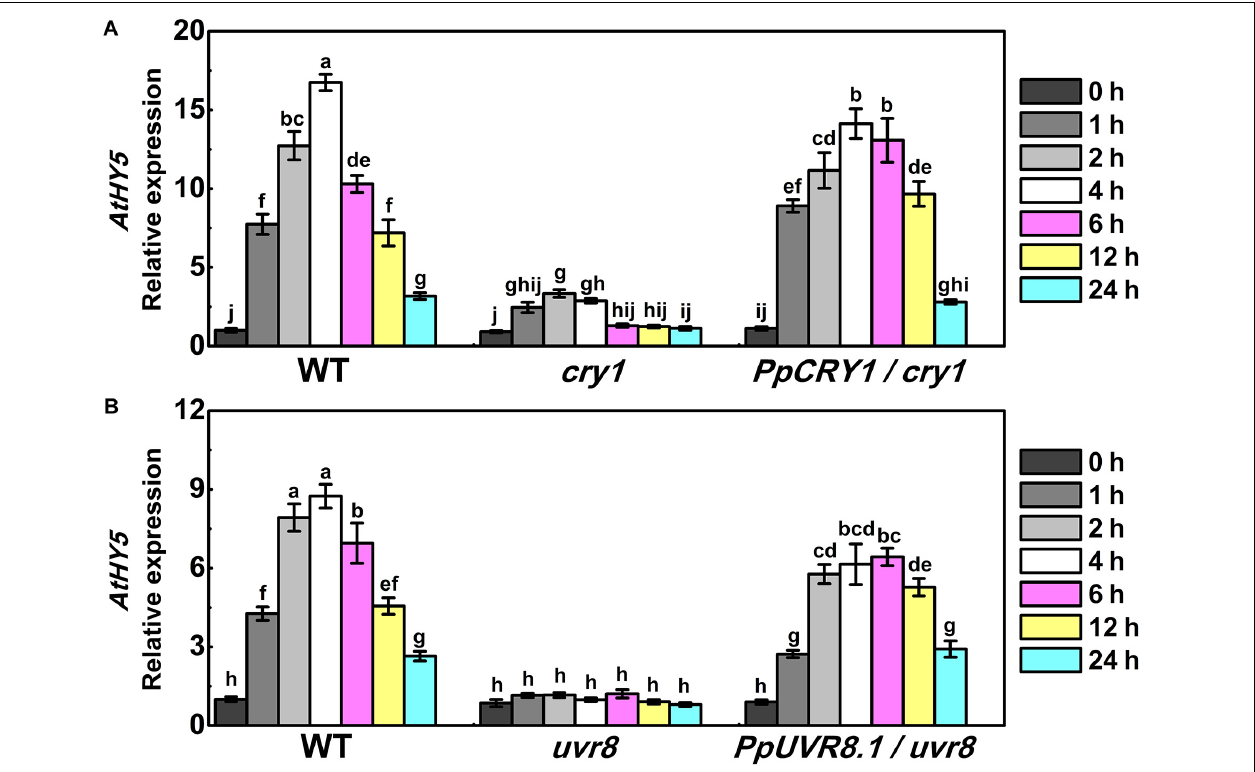
FIGURE 5 | The expression of AtHY5 in the wild type (WT), cry1 mutant and PpCRY1 / cry1 transgenic plant with different durations of continuous weak white light (WWL, 40 µ w/cm 2 ) + UVA irradiation (40 µ w/cm 2 ) (A) or in the WT, uvr8 mutant and PpUVR8 . 1 / uvr8 transgenic plant with different durations of continuous WWL (40 µ w/cm 2 ) + UVB irradiation (10 µ w/cm 2 ) (B) . For Arabidopsis transgenic plants, three independent lines for each target gene were used. 5-day-old seedlings grown under constant WWL were subjected to WWL + UVA or WWL + UVB irradiation for the indicated time span. Data were presented as means ( ± SE) from three independent biological replicates with 30 or more Arabidopsis seedlings collected for each